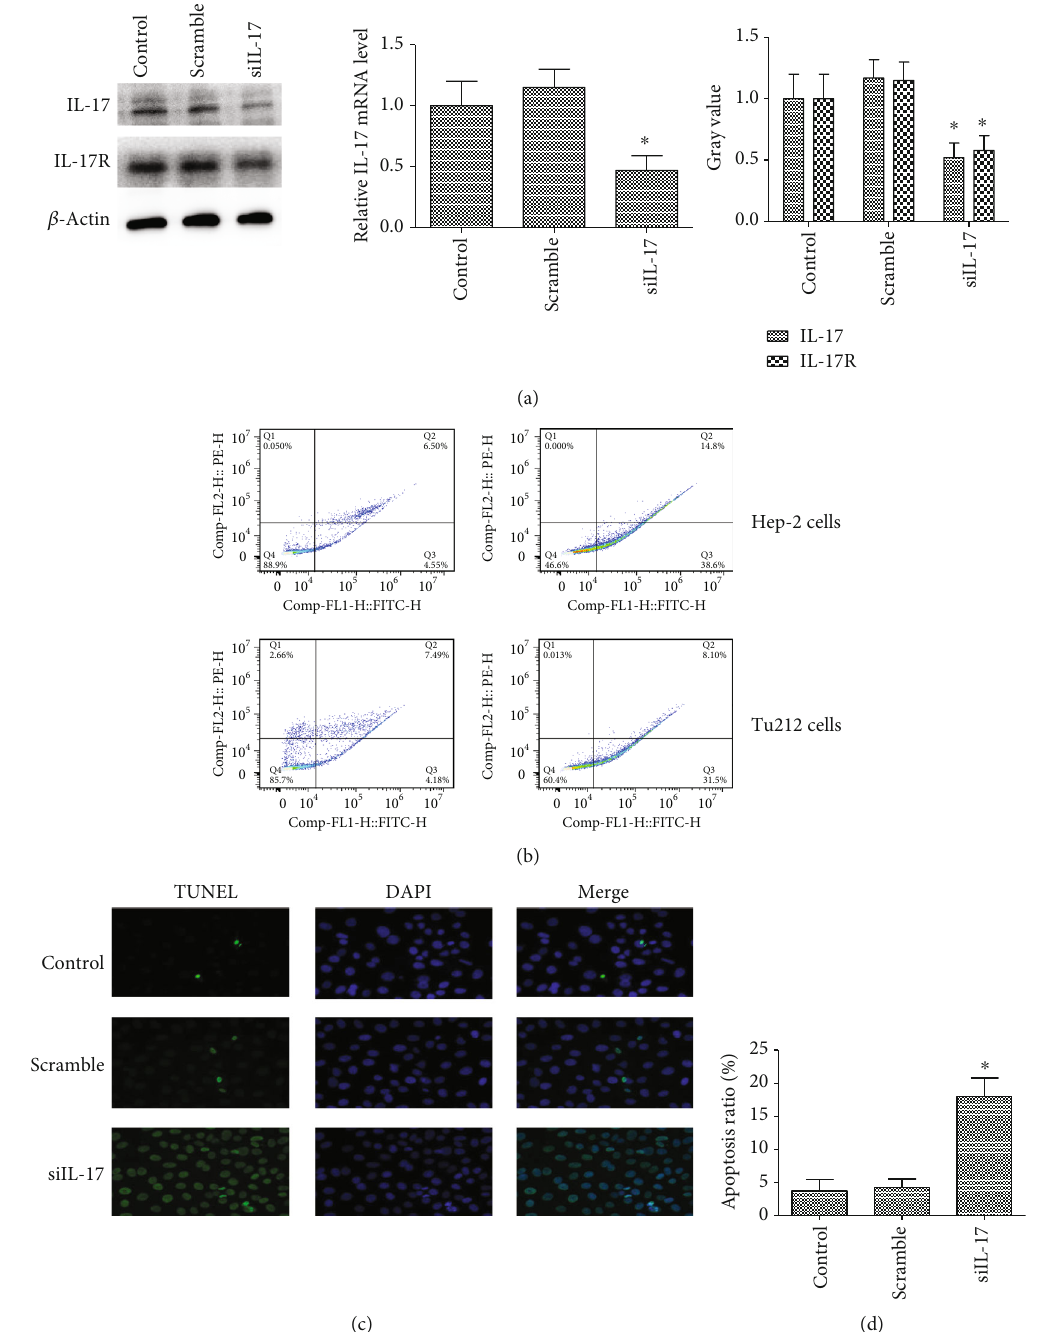
Figure 6: The role of silenced IL-17 in apoptosis of LC cells. (a) Transcriptional expression of IL-17. The real-time PCR revealed that there was a 63% decrease of IL-17 mRNA in LC cells transfected with IL-17 siRNA compared with the control. GAPDH was used as an internal control. One representative experiment of the three independent experiments is demonstrated. ∗ P < 0 : 01 compared with the control group. The expression of IL-17 in LC cells transfected with siRNA targeting IL-17 was detected with a Western blotting assay. The protein level of IL-17 was reduced to 73% by IL-17 siRNA. Each sample was tested in triplicate. One representative experiment of the three independent experiments is demonstrated. ∗ P < 0 : 01 compared with the control group. (b) siRNA-IL-17 promoted Hep-2 cell apoptosis (53.4% compared to 11.05% in control cells), while siRNA-IL-17 promoted Tu212 cell apoptosis (39.6% compared to 11.67% in control cells). One representative experiment of the three independent experiments is demonstrated. ∗ P < 0 : 01 versus the control. (c) siRNA-IL-17 promoted LC cell apoptosis. The TUNEL assay was conducted to detect the apoptotic cells in Hep-2 cells. Representative TUNEL staining results of di ff erent groups are shown in a scale bar = 50 μ m . (d) The percentages of apoptotic cells in all groups were calculated. Data are presented as mean ± SD . n = 7 in each group. Experiments were biologically repeated in triplicate. ∗ P < 0 : 01 compared to the control